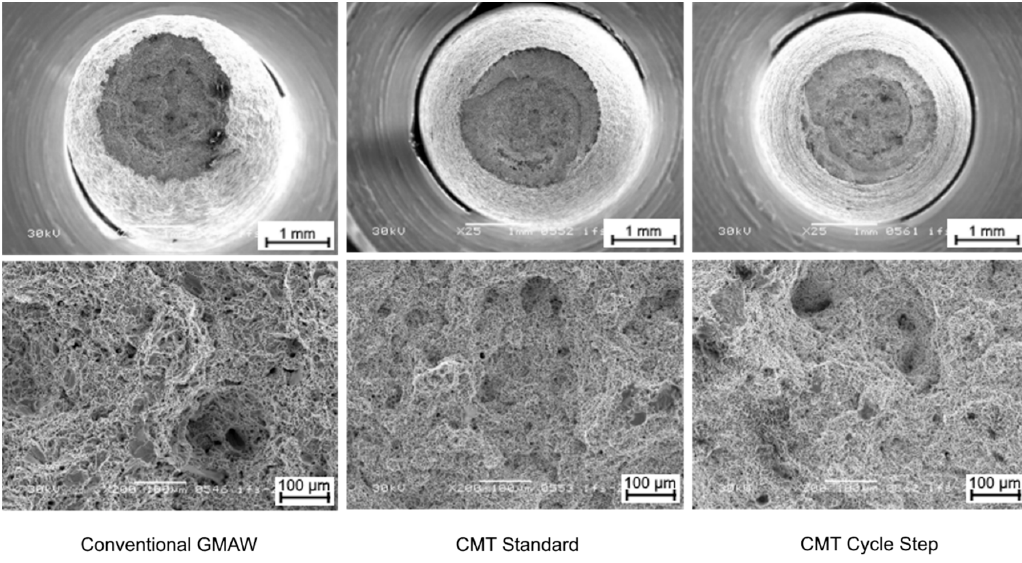
Figure 14. Fracture surface images of the bars after destructive tensile testing.